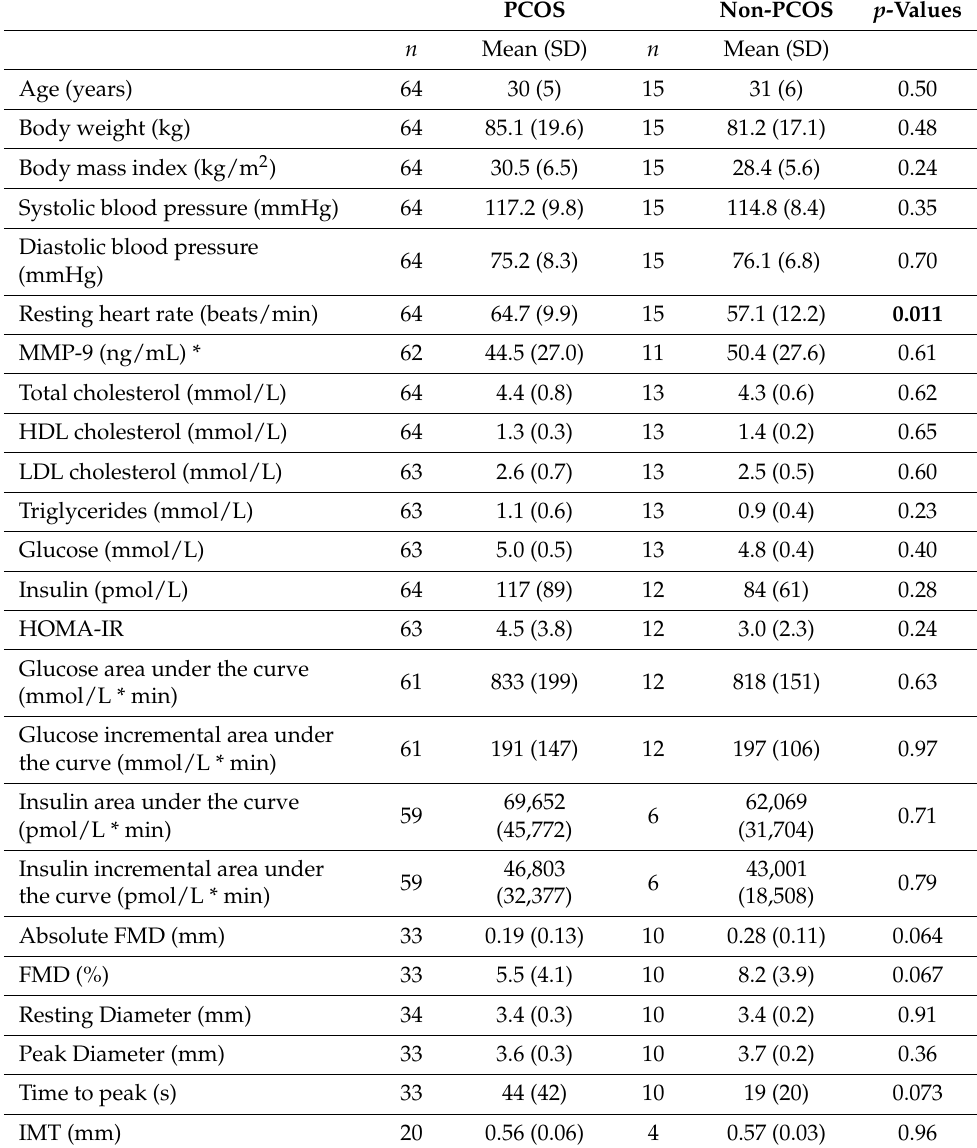
Table 1. Baseline characteristics of women with polycystic ovary syndrome (PCOS) and without PCOS